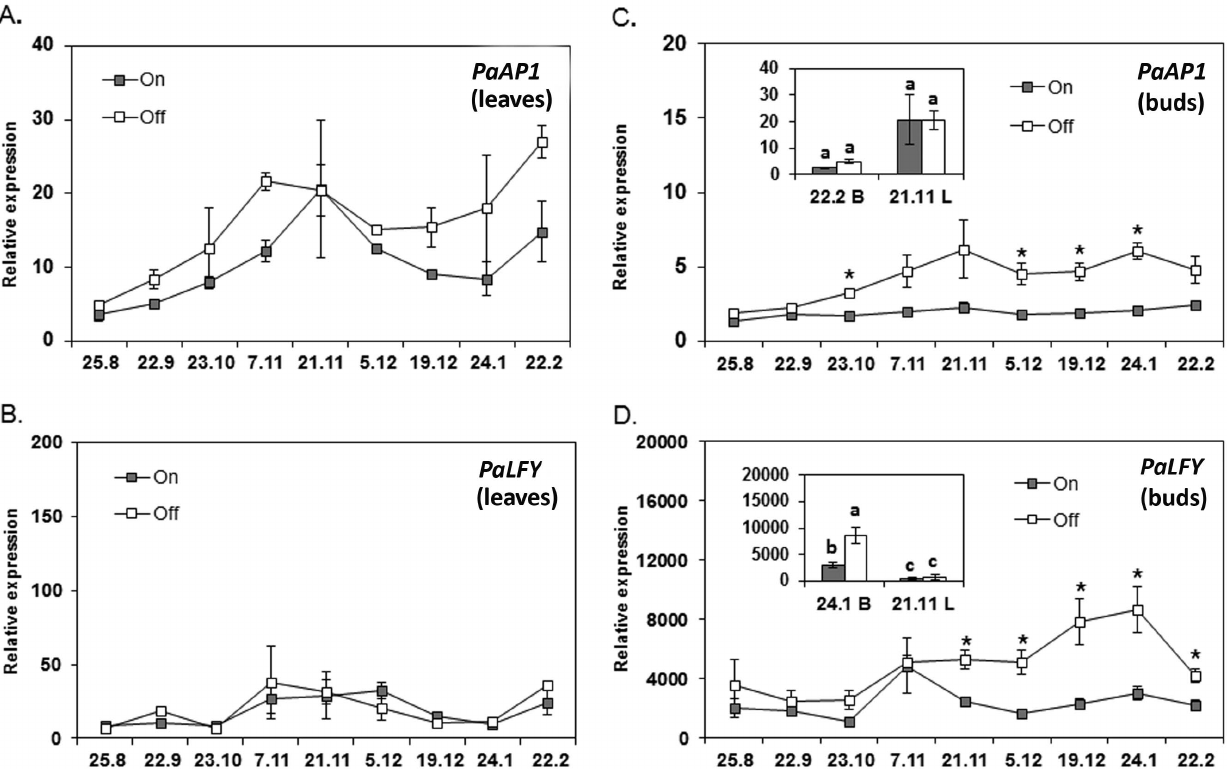
Figure 8. Seasonal expression profiles of PaAP1 and PaLFY . Seasonal expression profiles of PaAP1 and PaLFY in leaves (A–B) and buds (C–D) from fully loaded ( on ) and completely de-fruited ( off ) ‘Hass’ trees are shown. Off trees correspond to trees from which fruit load was completely removed in July. Data are means 6 SE of three independent replicates (n=3 trees). Stars denote a significant difference between the transcript expression in on and off tissues at the same time point ( P , 0.05). Insets: PaAP1 and PaLFY expression in leaves (L) vs. buds (B) ( C and D ), respectively. Different letters indicate statistically significant differences ( P , 0.05). Sampling dates are presented as dd/m.